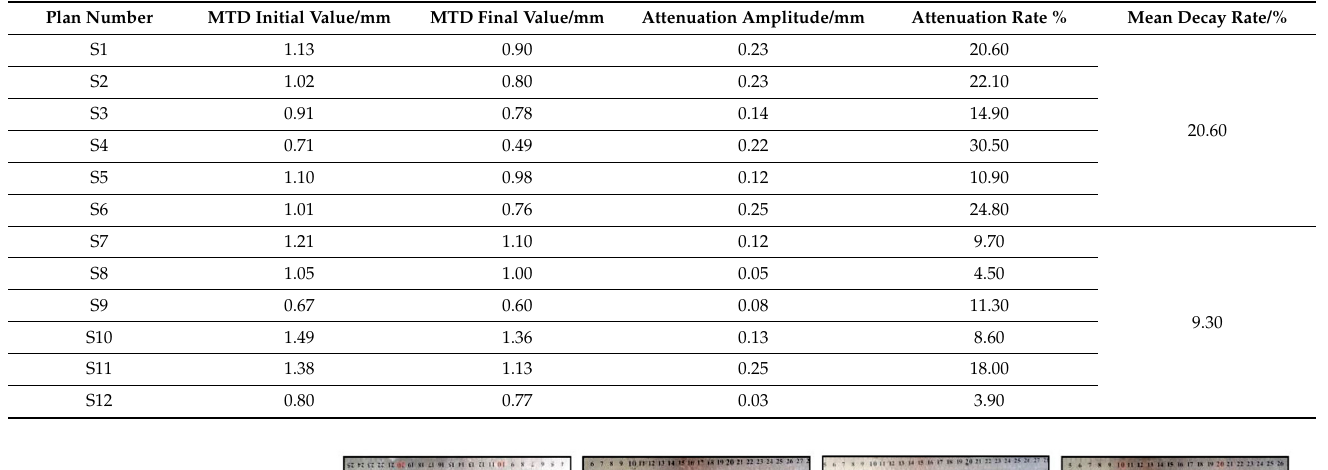
Figure 5. The relationship between MTD and accelerated loading times.